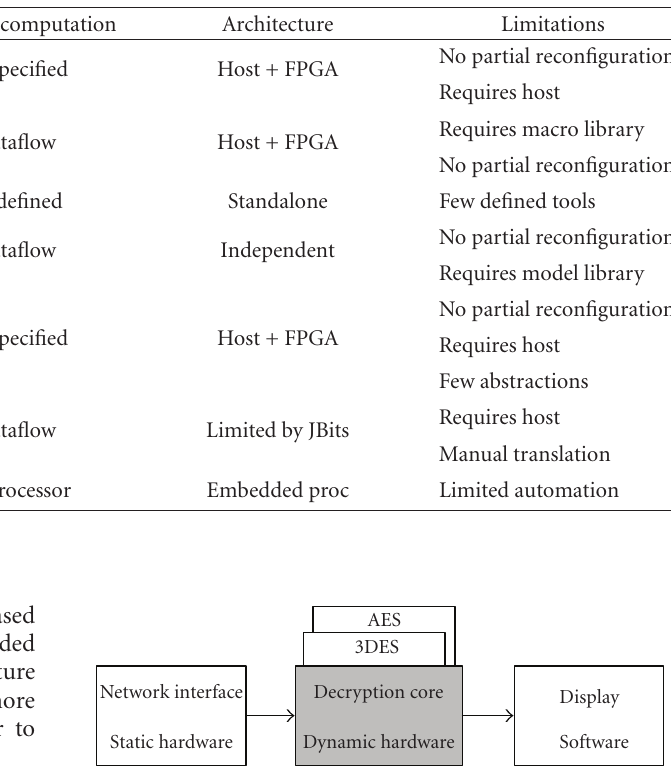
Table 1: Previous PR development environments.